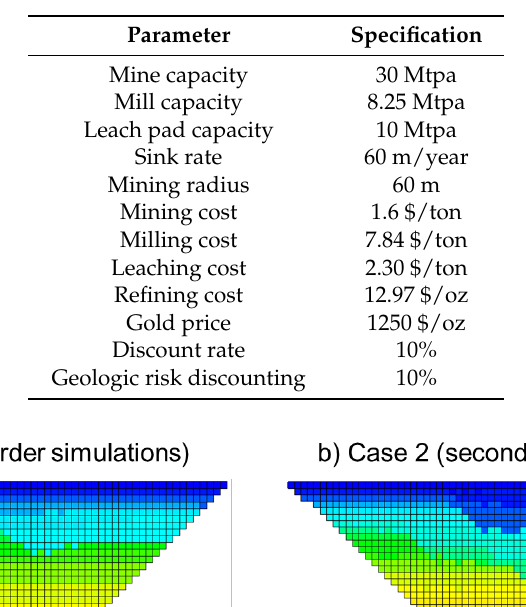
Table 1. Main parameter used in the optimization.